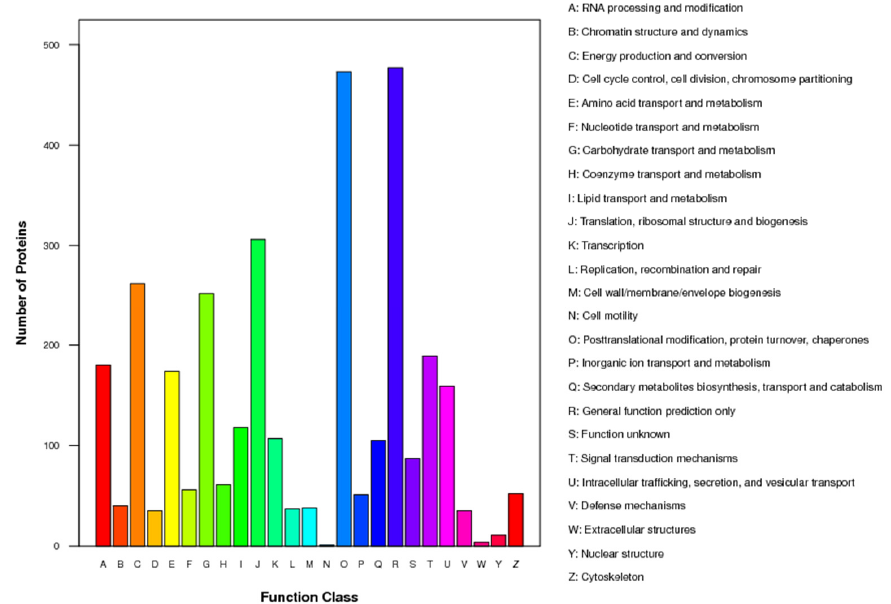
Figure 3. Basic Data ‐ Independent Acquisition (DIA) proteomics analysis output details. ( A ) Pep ‐ tides and protein species identified by a DIA database search; ( B ) length distribution of peptides; ( C ) molecular weight of peptides; ( D ) numbers of peptides that were matched to proteins.